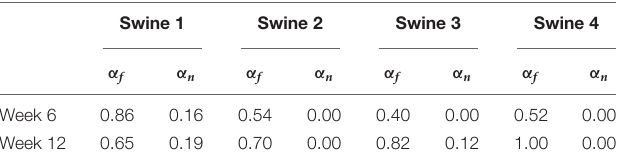
tends to underpredict chamber elongation, except for Swine